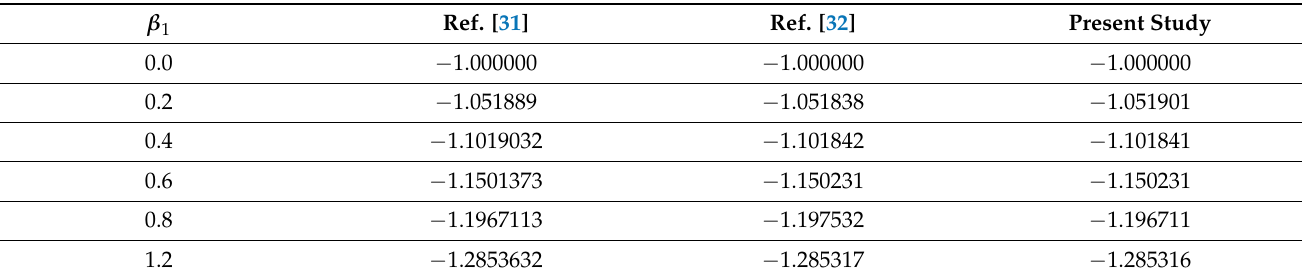
Table 2. Comparison of the results of f (cid:48)(cid:48) ( 0 ) for β 1 when A = δ = 0.